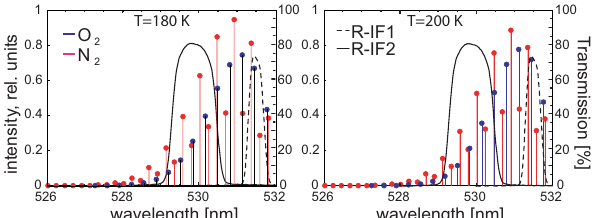
Fig. 2. The line-by-line pure rotational-Raman spectrum (only anti- Stokes) of O 2 (blue) and N 2 (red) calculated for T =180K (left panel) and T =200K (right panel) and the transmission curve of the two interference filters (R-IF1 with a central wavelength line (CWL) at 531.55nm and R-IF2 with a CWL at 529.45nm) produced by Barr Associates, Inc. The CWL of the laser is